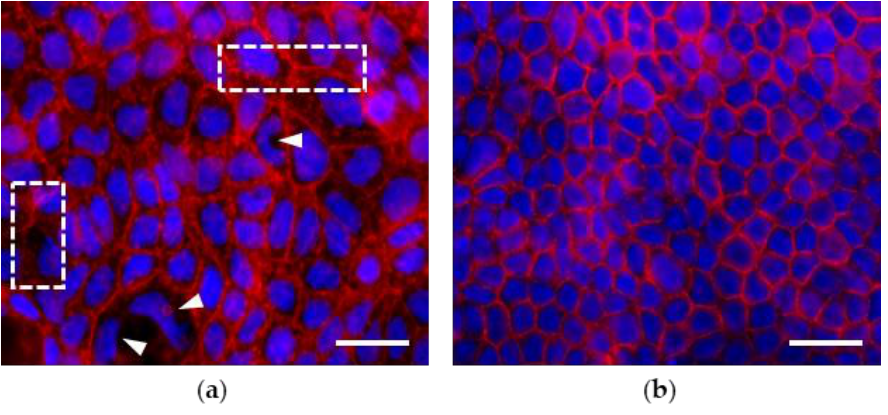
Figure 1. Morphology and organization of untreated Caco-2 monolayers. Cells were grown on coverslips for 7 ( a ) and 21 ( b ) days post-seeding (dps). At 7 dps ( a ), cells display different shapes and sizes and recurrence of amorphous nuclei (arrowheads), typical of undifferentiated tumor-like cells. Actin elements appear heterogeneously marked with evident vs. irregular cell-cell contact structures (rectangles). Contrariwise, 21 dps enterocyte-like cells ( b ) show regular polygonal geometry, small-size, and regular nuclei compared to the 7 dps monolayer ( a ). Circumferential actin belt is clearly visible, highlighting regular cell-cell-cytoskeletal junctions ( b ). Phalloidin-TRITC and Vectashield Mounting Medium with DAPI were used for the detection of actin elements (red) and nuclei (blue). Scale bar: 100 µm.